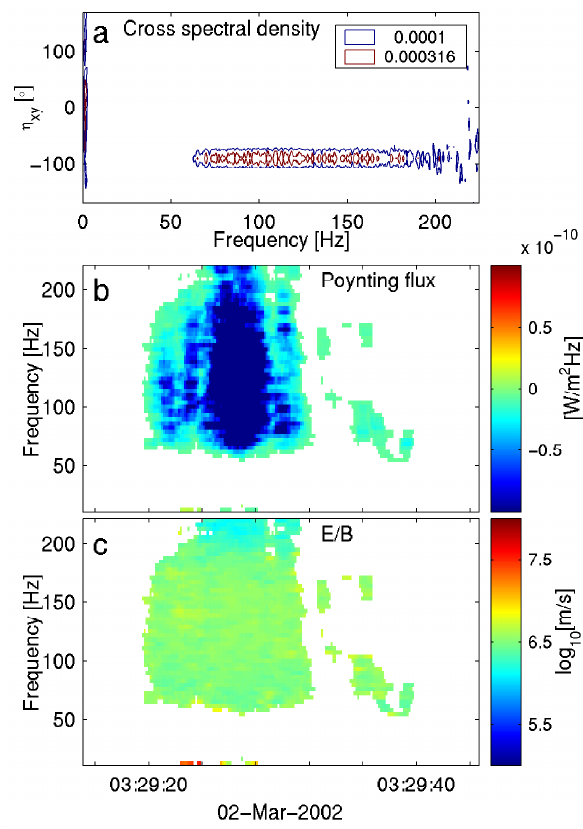
Fig. 2. (a) Contours showing the distribution of cross spectral den- sity, S xy in frequency, f , and phase, η xy . The cross spectrum is computed for the interval 03:29–03:30 UT using a record length of 1024 points and averaging over 101 time records. The cross spectral density is in units of (nT) 2 / ◦ Hz. Integrating over all phase angles would yield the usual cross spectral density in (nT) 2 /Hz. (b) Parallel component of the Poynting flux, assuming E × B 0 = 0. The whistler mode waves propagate anti-parallel to the background field. Time- frequency bins with a Poynting flux less than 2 · 10 − 6 µ W / m 2 Hz are removed. (c) E/B versus time and frequency provides an es- timation on the phase velocity, which for the waves of interest is about 5 · 10m/s. STAFF and EFW data are